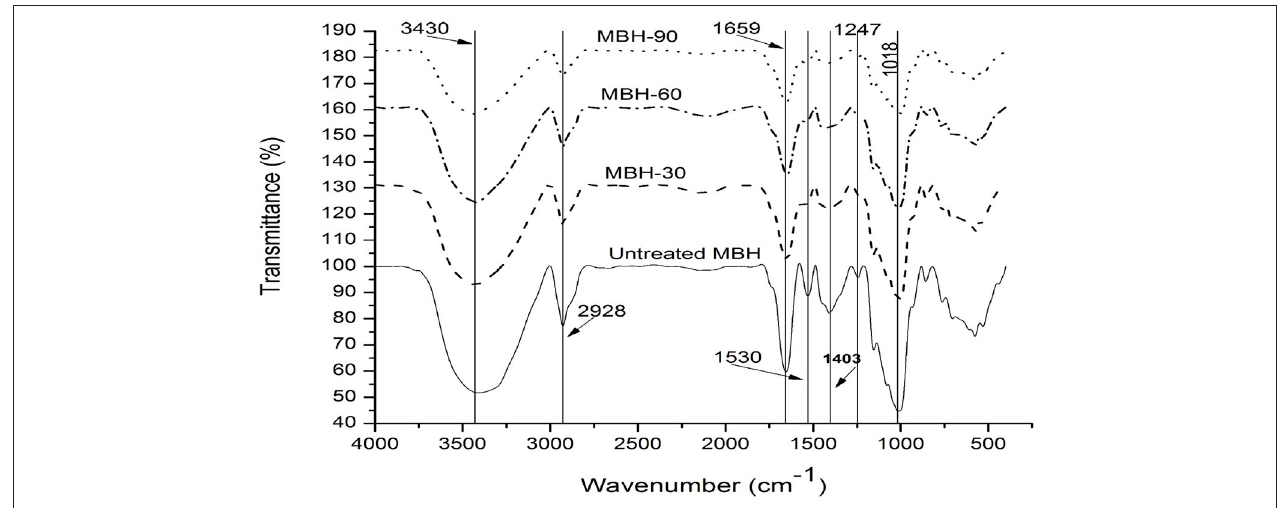
FIGURE 12 | The FT-IR spectra of MBH samples.